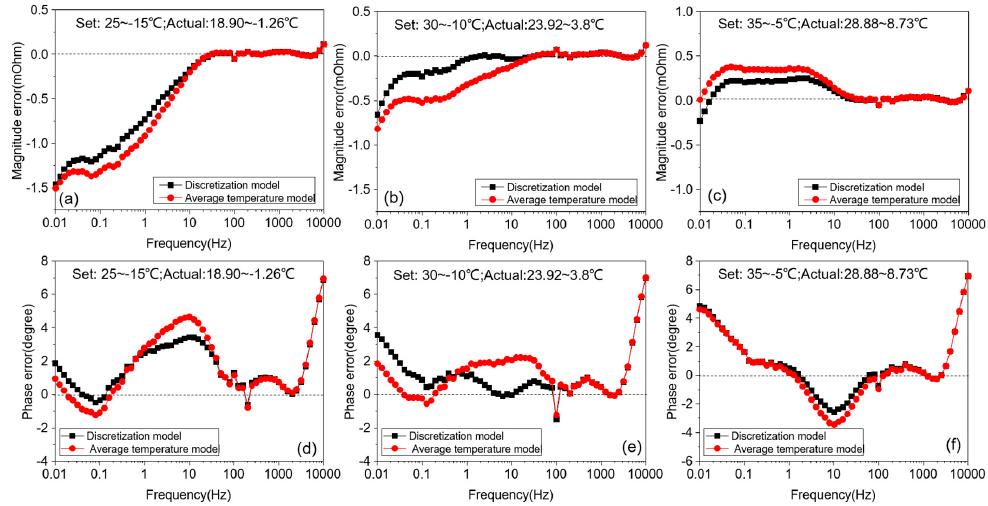
Figure 19. Errors of the discretization model and the lumped model: ( a – c ) impedance magnitude errors; ( d – f ) impedance phase errors. Table 3. Statistical data of the discretization model and the average temperature model.